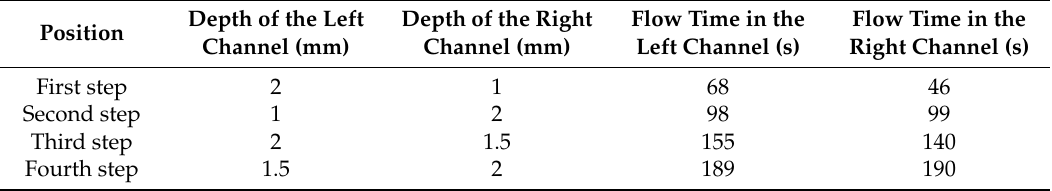
Table 2. Flow time of two channels.